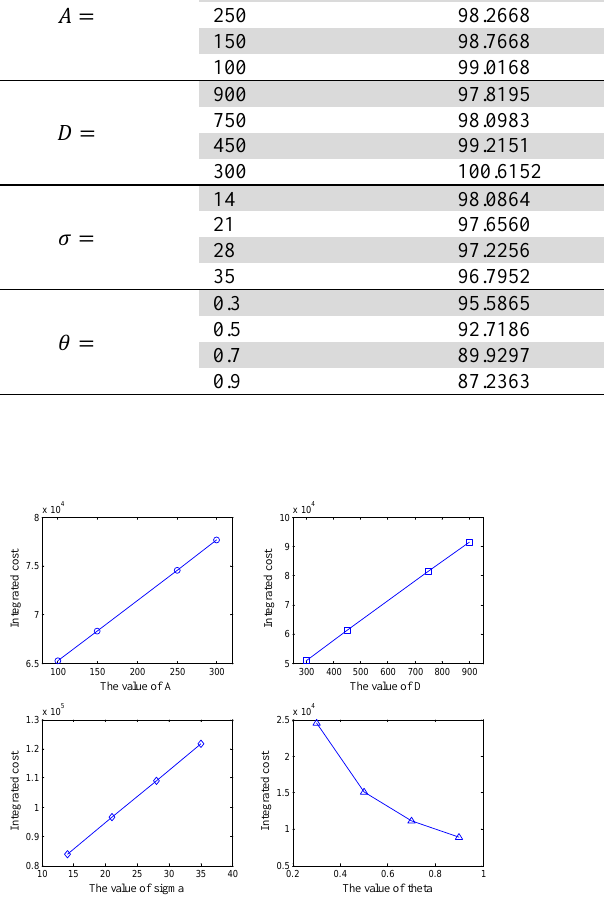
Fig. 2. Graphical representation of sensitivity analysis for numerical example 1